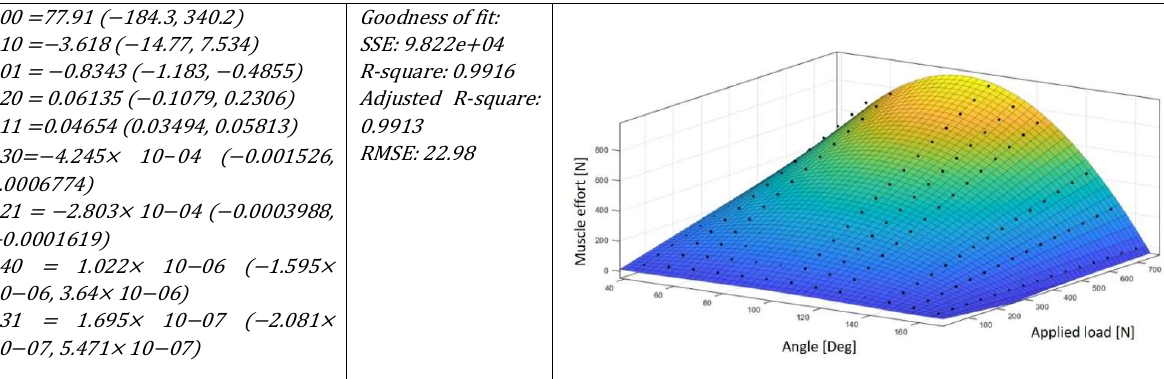
Figure 15. General formulation of short biceps efforts in function of wrist load (W) and elbow angle ( α ) and surface reconstruction of the proposed polynomial.